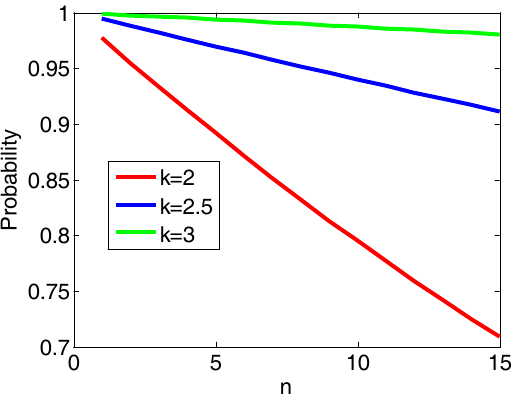
Figure 4. The probability of P ( r mi < r ai − k σ i ) with different k and n .